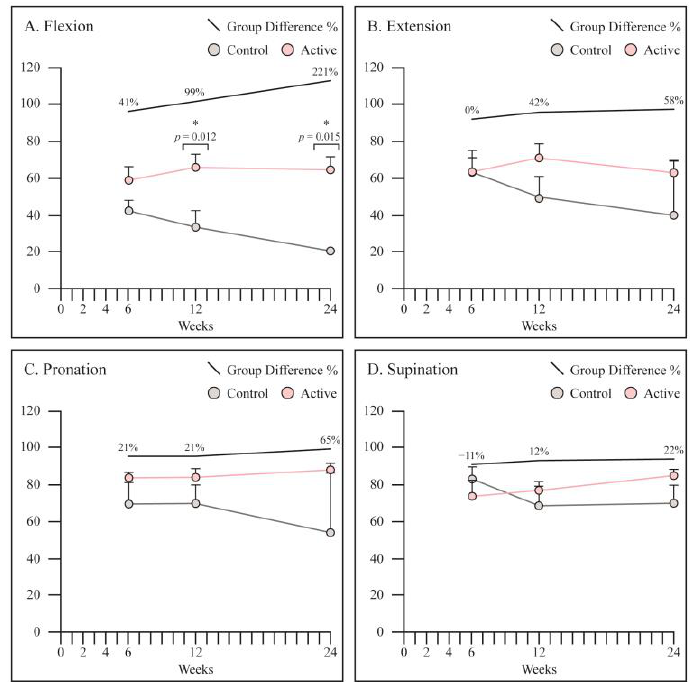
Figure 5. Assessment of functional outcome in terms of wrist range of movement as measured at 6, 12 and 24 weeks. ( A ) Flexion was significantly better in the PEMF treated patients at 12 and 24 weeks. ( B – D ) All other parameters were slightly better in PEMF treated group, however not statistically significant. Graphs are reported as mean ± SE. Student’s t -test. * Statistically